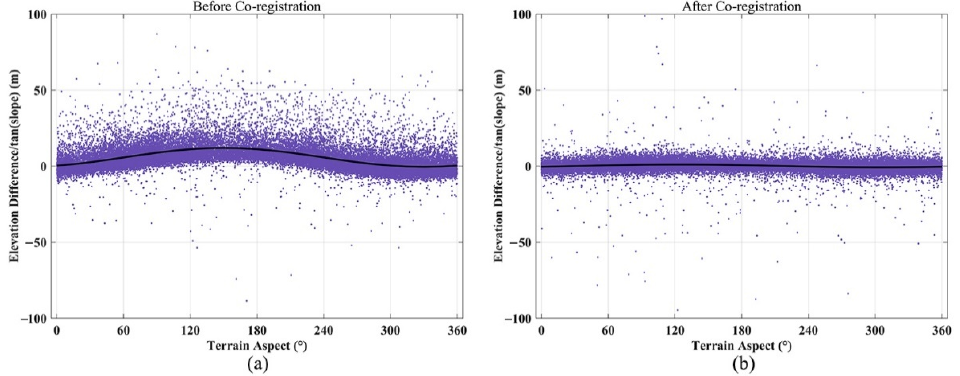
Figure 4. The distribution of normalized elevation differences in terrain aspect over stable regions ( a ) before and ( b ) after DEM co ‐ registration.